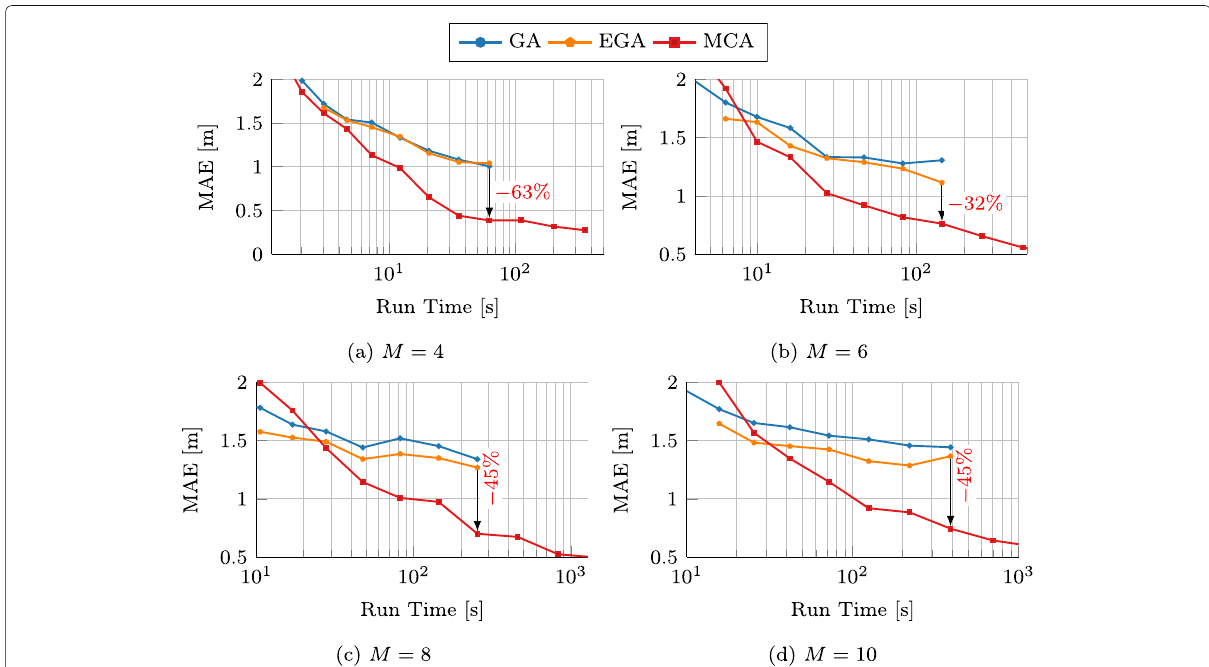
Fig. 11 Localization performance as a function of run time for 1500 PPA and for different numbers of agents: a four agents, b six agents, c eight agents, and d ten agents